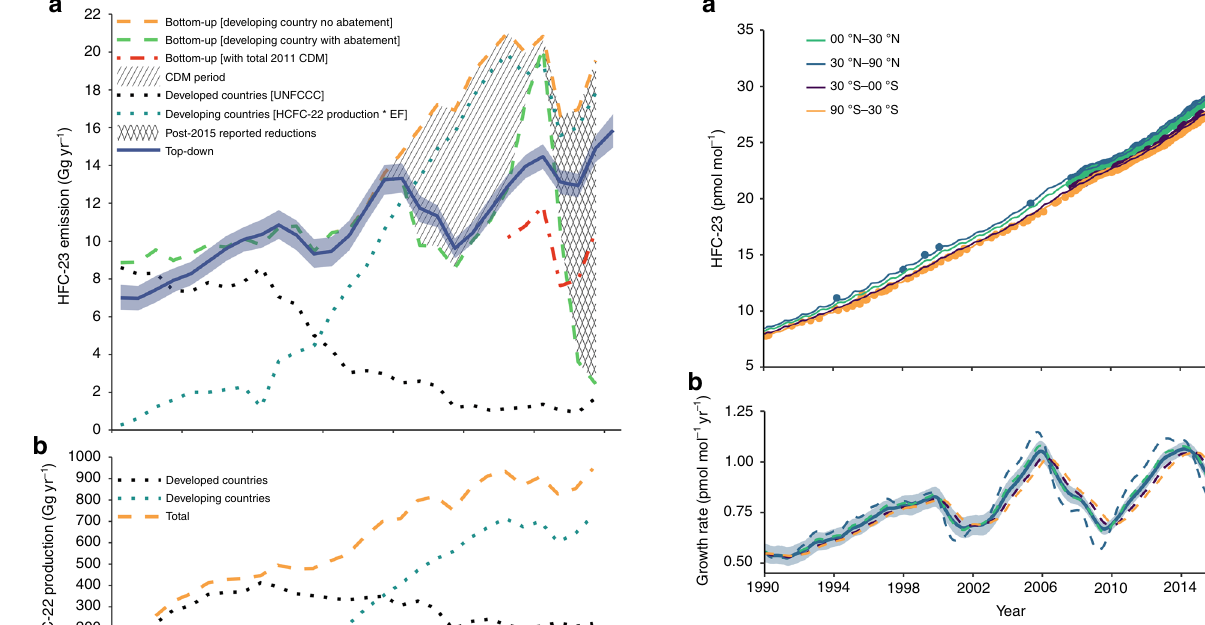
respectively. b Total HCFC-22 production (dashed orange line) from (black dotted line). All data points are shown as the mid-point of the respective year.